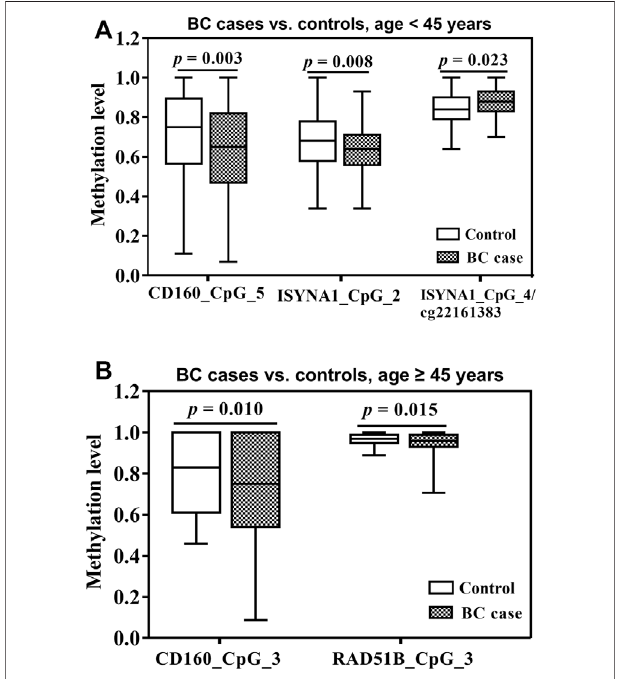
FIGURE 3 | Association between blood-based methylation of CD160 , ISYNA1 ,and RAD51B andBCstrati fi edbyage(45 years).Theboxplotsshow the distribution of DNA methylation levels in BC cases and controls. The p values were calculated by logistic regression adjusted for age and different batches for the measurements. (A) Association between blood- based methylation of CD160 , ISYNA1 , and RAD51B and BC in subjects < 45 years old combining validation I and validation II (B) Association between blood-based methylation of CD160, ISYNA1, and RAD51B and BC in subjects ≥ 45 years old combining validation I and validation